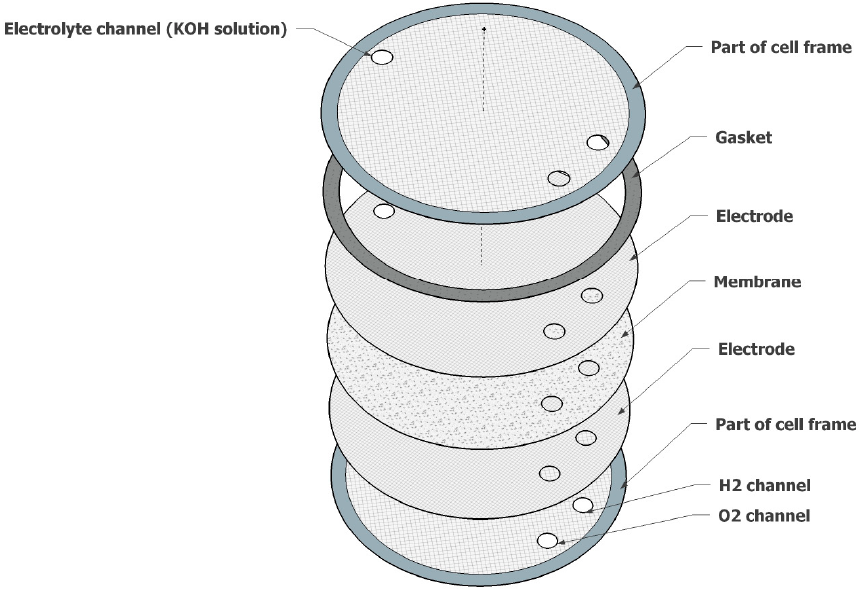
Figure 1. Alkaline electrolysis cell set-up (based on [22]).